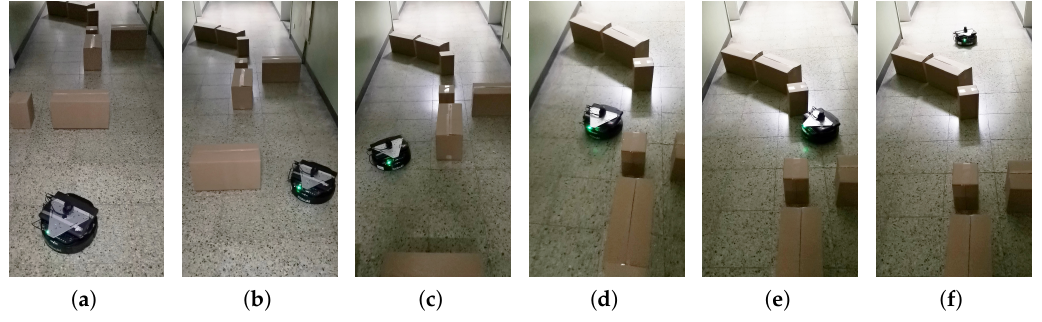
Figure 14. The scenario of real experiment.